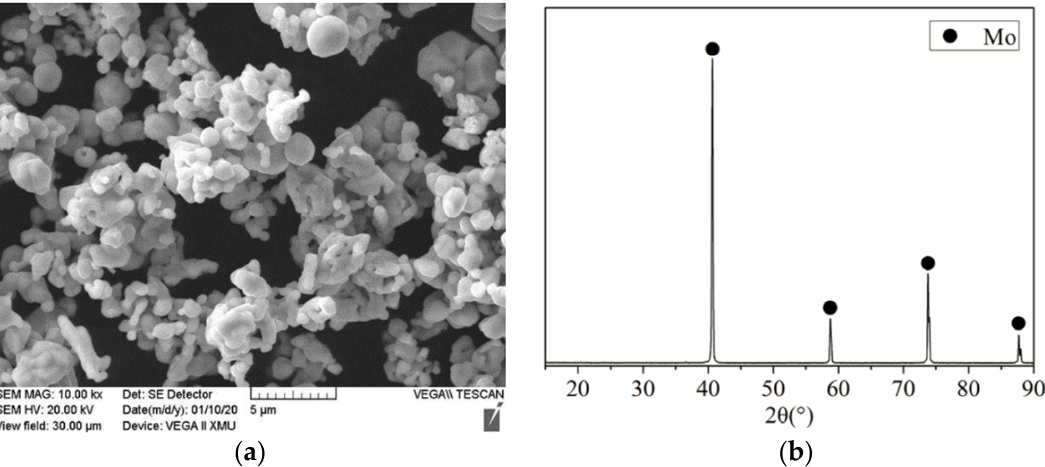
Figure 1. Micromorphology ( a ) and XRD result ( b ) of Mo powder.